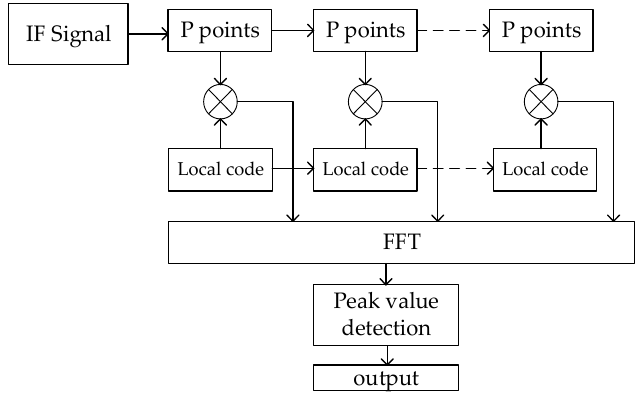
Figure 3. Structure of the PMF-FFT method.